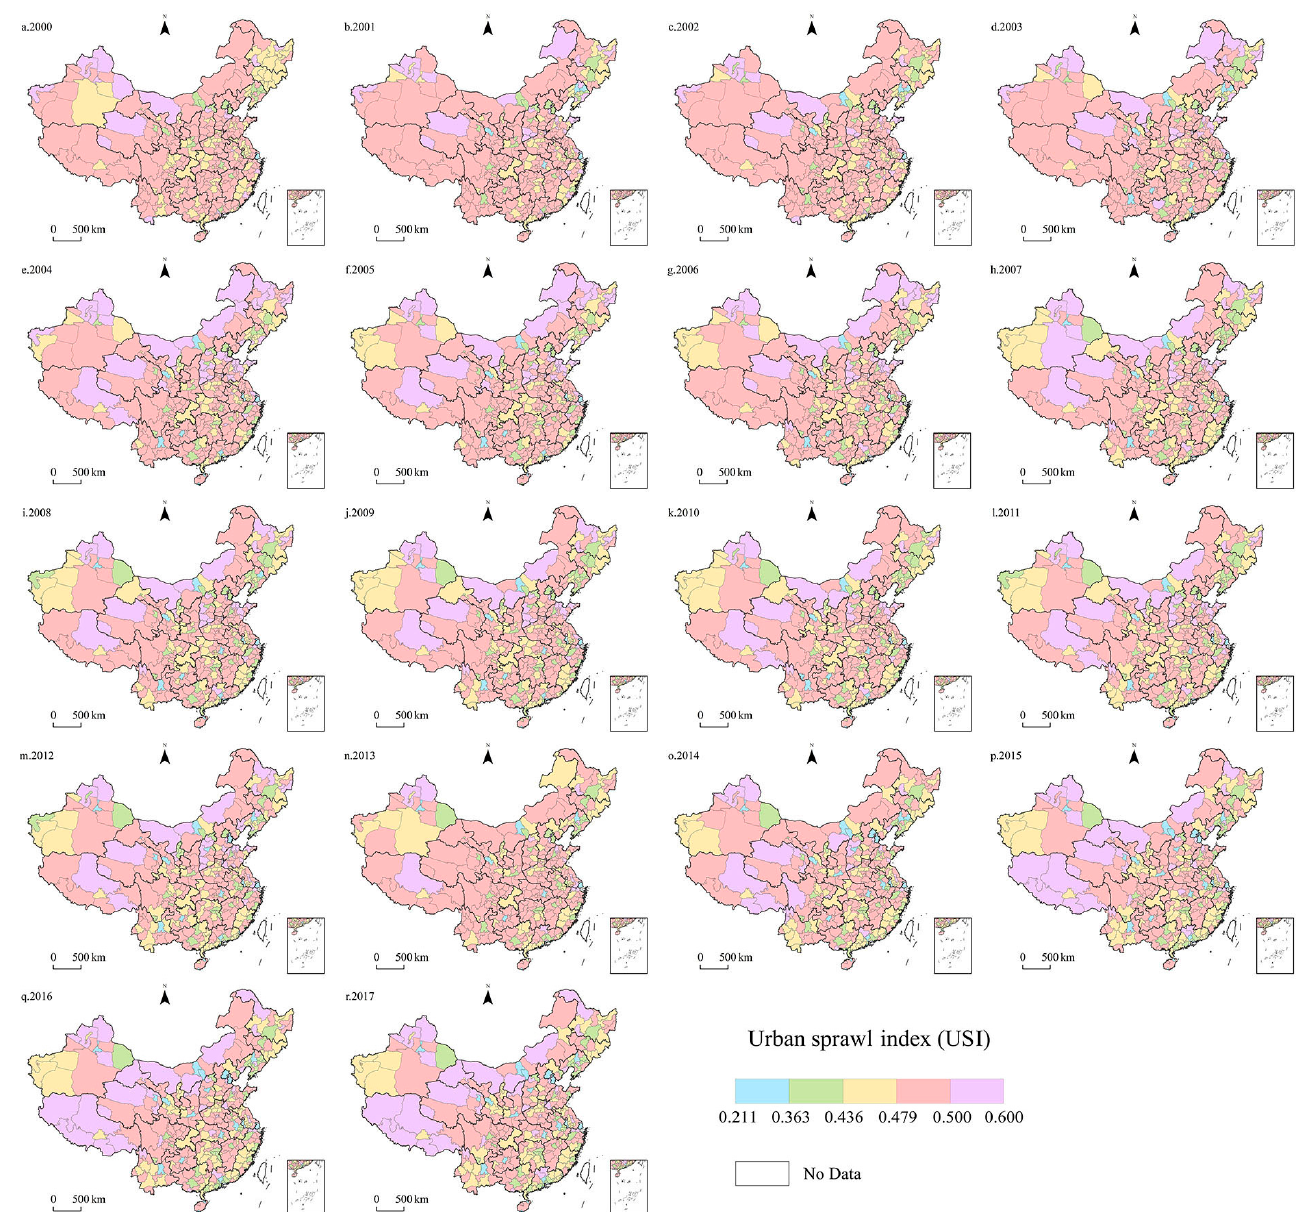
Figure 2. Spatial distribution of USI in China from 2000 to 2017.